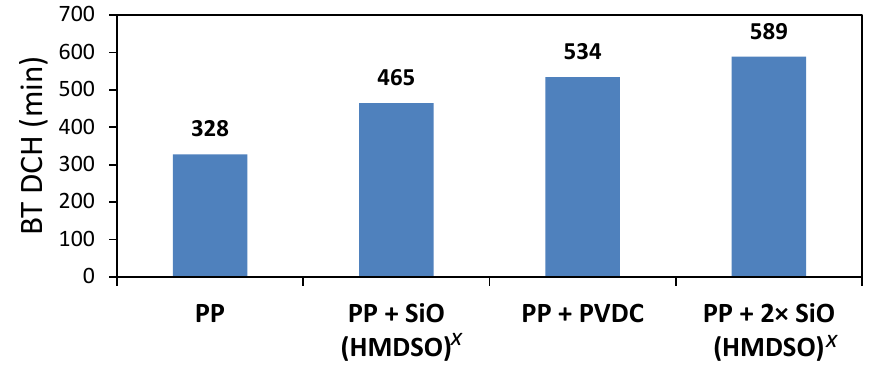
Figure 4. Resistance of the PP foil modified with different barrier layers against DCH permeation.